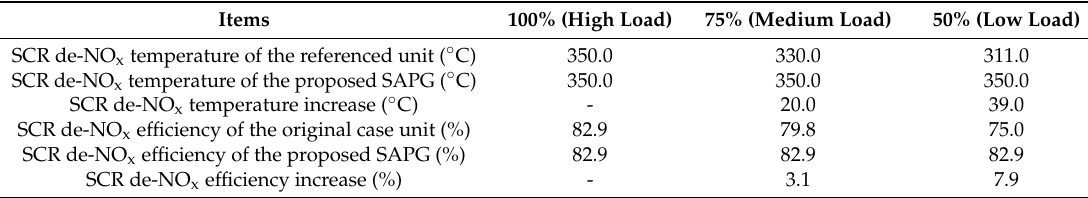
Table 9. SCR de-NO x performance improvement of the proposed SAPG.